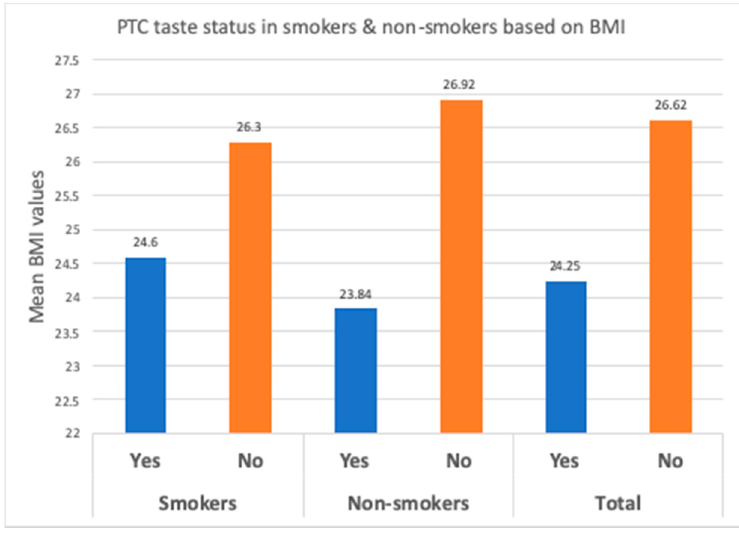
Figure 10. PTC tasting ability according to BMI in smokers and nonsmokers. Table 3. Comparison of PTC tasting status with FPAP scores in smokers, nonsmokers, and all subjects by the independent t